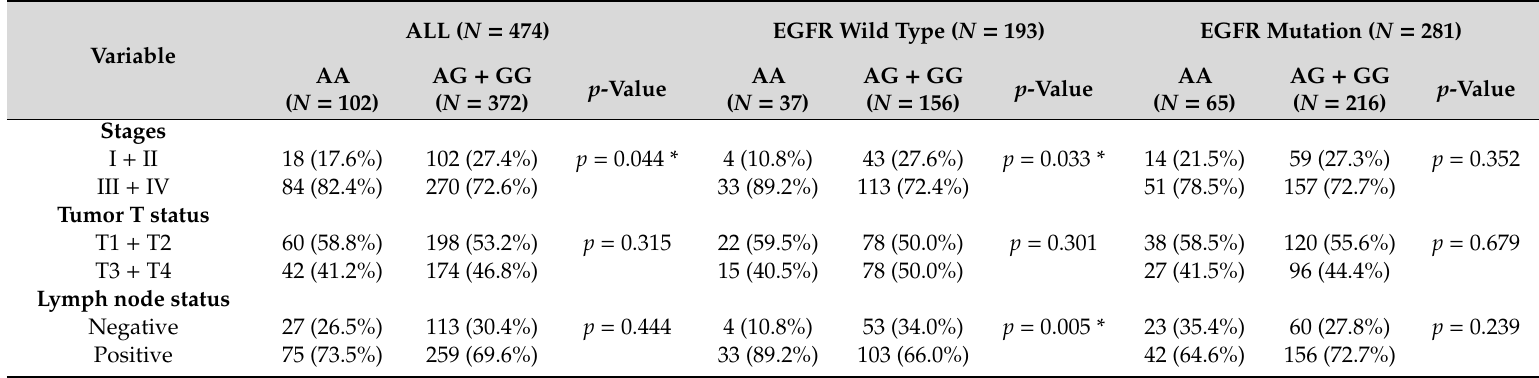
Table 4. Clinicopathologic characteristics of lung adenocarcinoma patients with epidermal growth factor receptor mutation, stratified by polymorphic genotypes of carbonic anhydrase 9